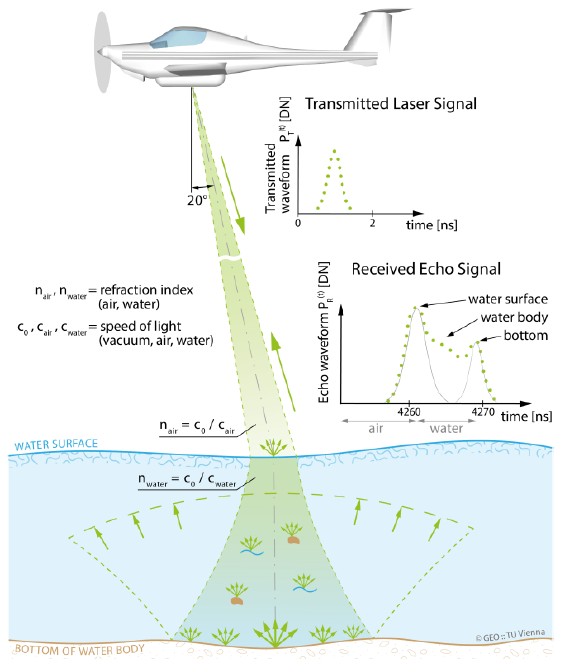
Figure 1. Diagram explaining ALB. See text for further information (©Department of Geodesy and Geoinformation Research Group Photogrammetry,